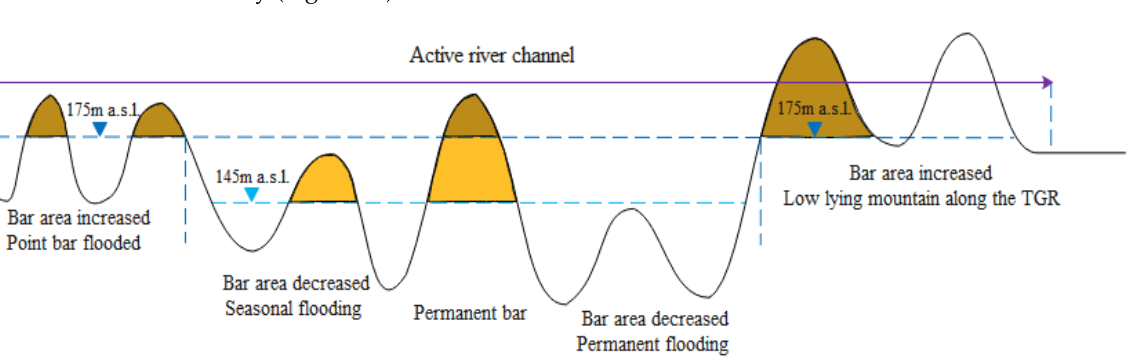
Figure 10. Schematic diagram of impacts of water-level rising on MCBs of the TGR.